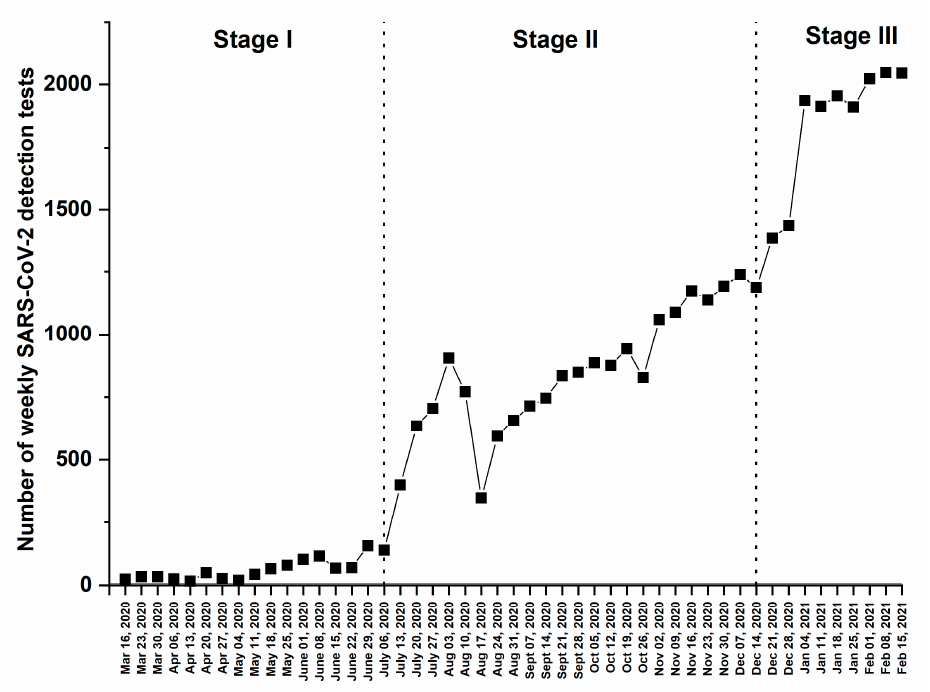
Figure 1. Number of weekly SARS-CoV-2 detection tests performed between 16 March 2020 and 21 February 2021.